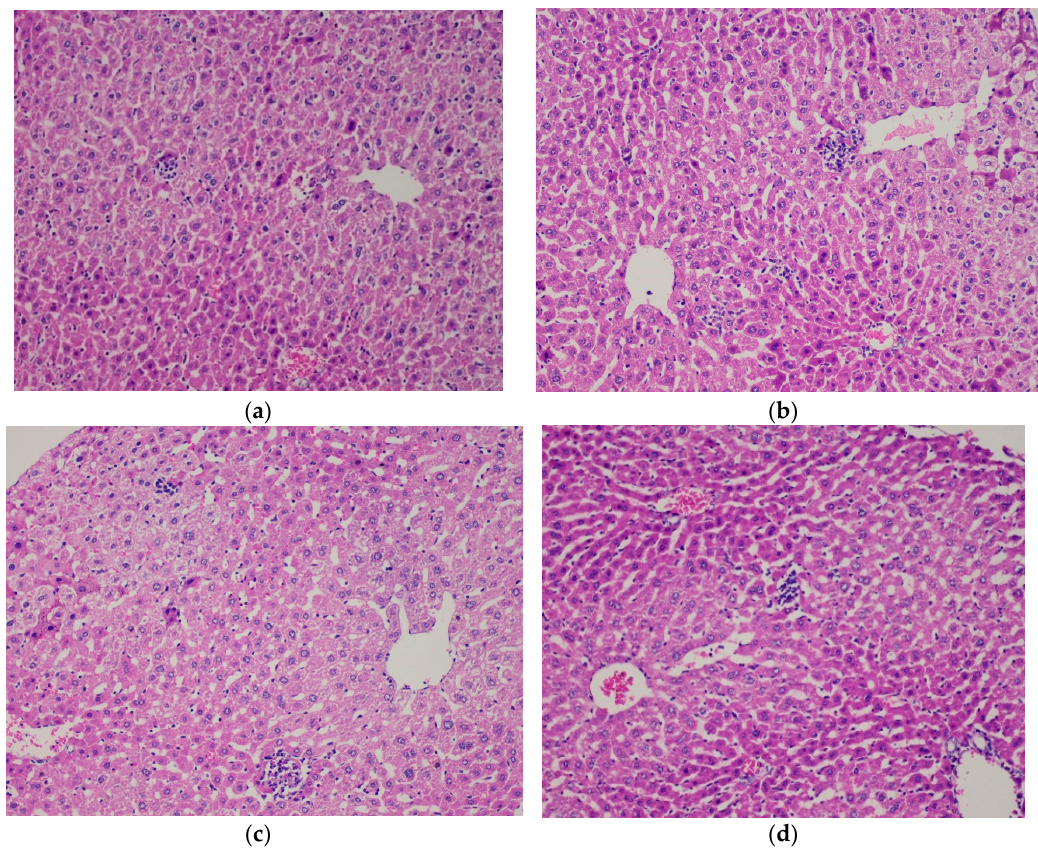
Figure 4. Liver tissue images of mice receiving a fixed dose of 2000 mg/kg and 5000 mg/kg of tocosh flour. (Stained with H&E, 200×). ( a ) Male group at the dose of 2000 mg/kg. Liver parenchyma with few lymphocytes around the central vein. ( b ) Female group at the 2000 mg/Kg dose. Liver parenchyma with isolated lobular lymphocytes (mild lobular inflammation). ( c ) Male group at the dose of 5000 mg/Kg. Liver parenchyma with isolated lobular lymphocytes (mild lobular inflammation). ( d ) Female group at the dose of 5000 mg/kg. Liver parenchyma with isolated lobular lymphocytes (mild lobular inflammation).